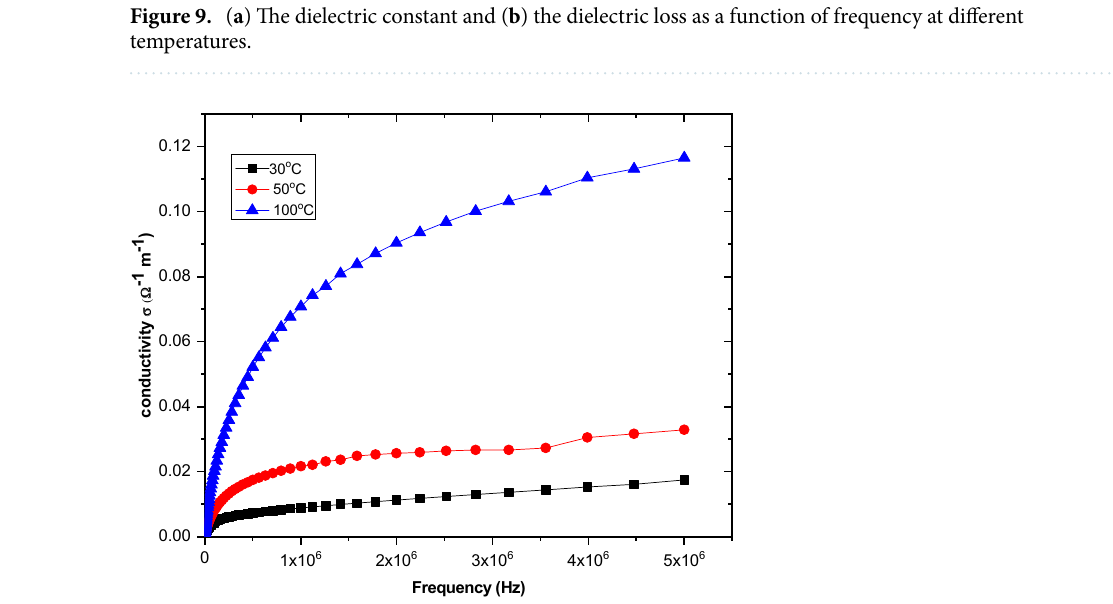
Figure 10. Frequency dependence of AC conductivity of Zn–Fe LDH at different